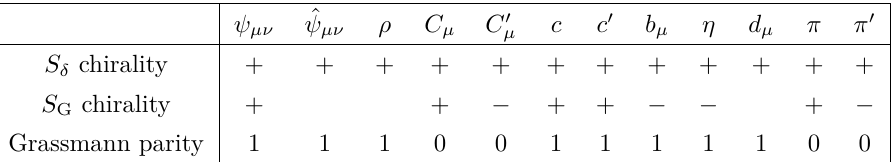
Table 4 . The chirality of the various fields appearing in the gauge-fixed actions (4.32) and (4.39) for the chiral fermionic two-form. Notice that it can depend on the gauge-fixing scheme. Grassmann parity is also included; even fields have abnormal